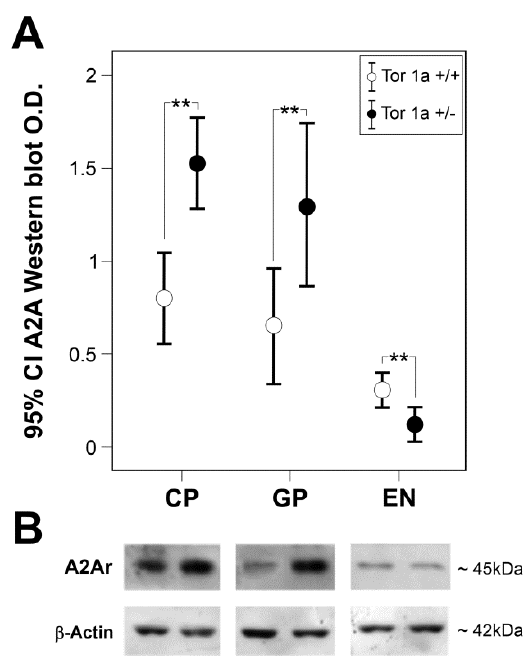
Figure 1. Expression of A2A in basal ganglia of Tor1a+/+ and Tor1a+/– mice. ( A ) Densitometric analysis optical density (O.D.) of A2A-immunostained bands in correspondent areas of caudate– putamen (CP), globus pallidus (GP), and entopeduncular nucleus (EN) of Tor1a+/+ and Tor1a+/ − . Results were expressed as the mean ± SD of the values obtained in each group. One-way ANOVA, ** p < 0.020. ( B ) Representative immunoblots of A2A content in correspondent area of CP, GP and EN of Tor1a+/+ and Tor1a+/- mice. As an internal reference standard, the β -actin content was de- tected in each lane of the same blots to correct for protein loading.